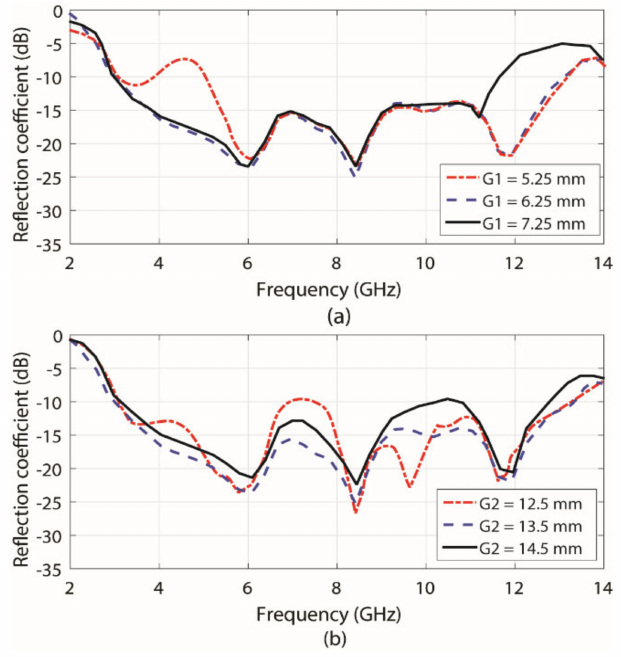
Figure 3. The parametric study of ground plane ( a ) width effects, ( b ) length